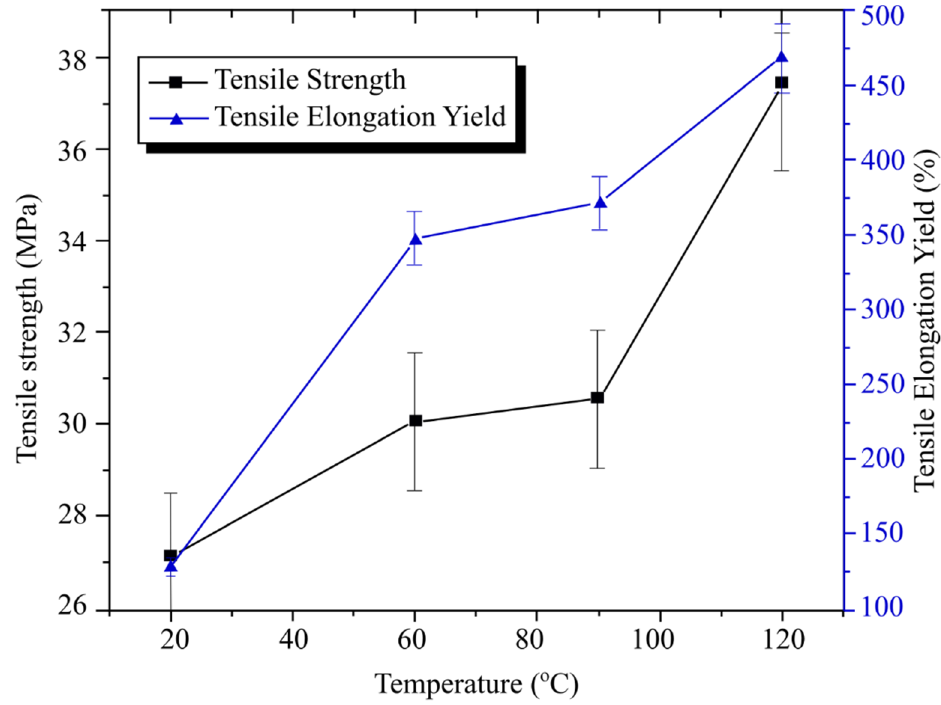
Figure 16. The mechanical properties of samples under different mold surface temperatures [49].